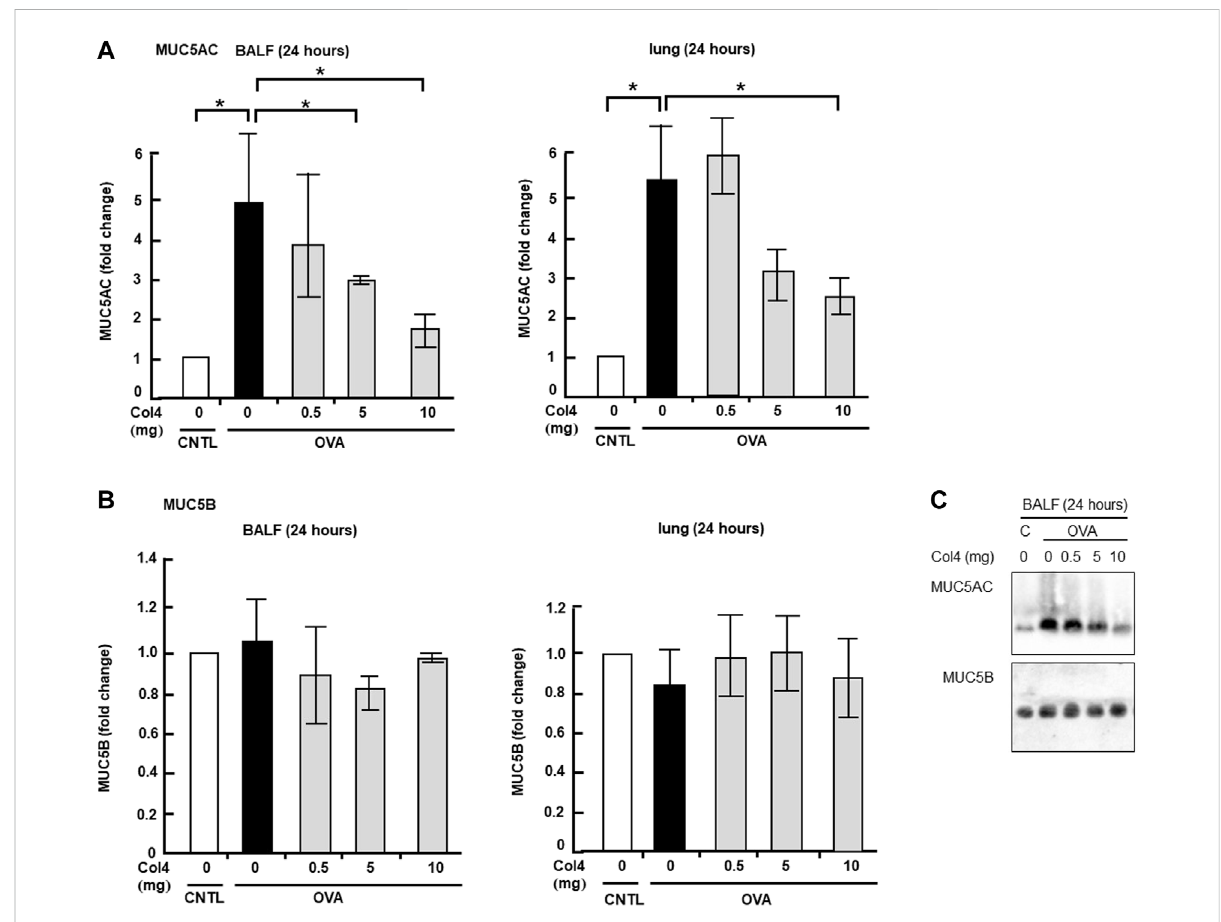
FIGURE 3 EffectsofCol4oncellularandsecretedmucin5AC(MUC5AC)andmucin5B(MUC5B)levelsinovalbumin(OVA)-sensitizedmice. (A) Thecontrolmice (CNTL) and OVA-sensitized mice (OVA) were exposed to Col4 at various concentrations (0 – 10 mg). After 24 h of Col4 exposure, MUC5AC levels in bronchoalveolarlavage fl uid(BALF)orlungtissuesamplesweredetectedusingthedot-blotmethodandmeasured. (B) TheOVA-sensitizedmicewereexposed toCol4atvariousconcentrations(0 – 10 mg).After24 hofCol4exposure,MUC5BlevelsinBALForlungtissuesamplesweredetectedusingthedot-blot methodandmeasured. (C) The control mice (C)andOVA-sensitizedmice(OVA)wereexposedto Col4at variousconcentrations(0 – 10 mg). After 24 hof Col4exposure,MUC5AC,andMUC5BlevelsinBALFsamplesweredetectedusingtheimmune-blotmethodwithagarosegel.TheMUC5ACandMUC5Bprotein levelsinlungtissuesampleswerenormalizedtotheGAPDHlevelsbeforeanalysis.Thecontrolmiceandthemicetreatedwith0 mgofCol4wereexposedtoPBS aloneatthesametime.Foldchangeswerebasedontheratiobetweenthevalues[mean±standarddeviation(SD), n =5].Aone-wayanalysisofvariancewasused to obtain the p -values. Asterisks indicate statistical signi fi cance, * p < 0.05. Representative results of three independent experiments are